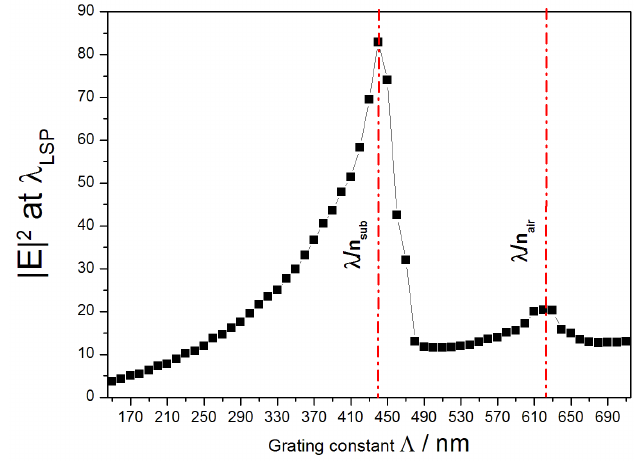
Figure 3. Calculated intensity of the local electric field at the maximum of the LSP mode wavelength versus the grating constant. Calculations are made by the FDTD method for gold discs (D = 100 nm and h = 50 nm).